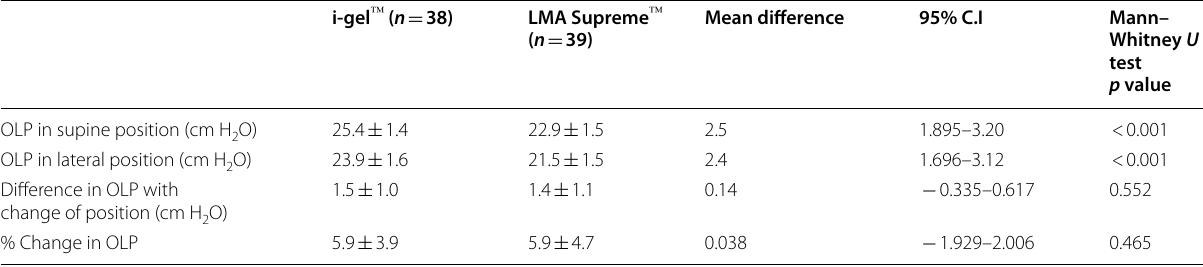
Values are expressed as mean OLP oropharyngeal leak